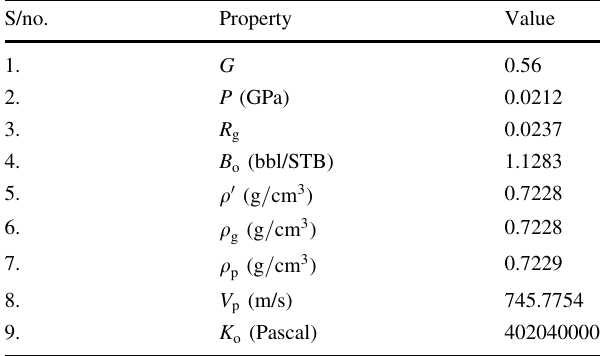
Table 2 Computed properties of live oil S/no.